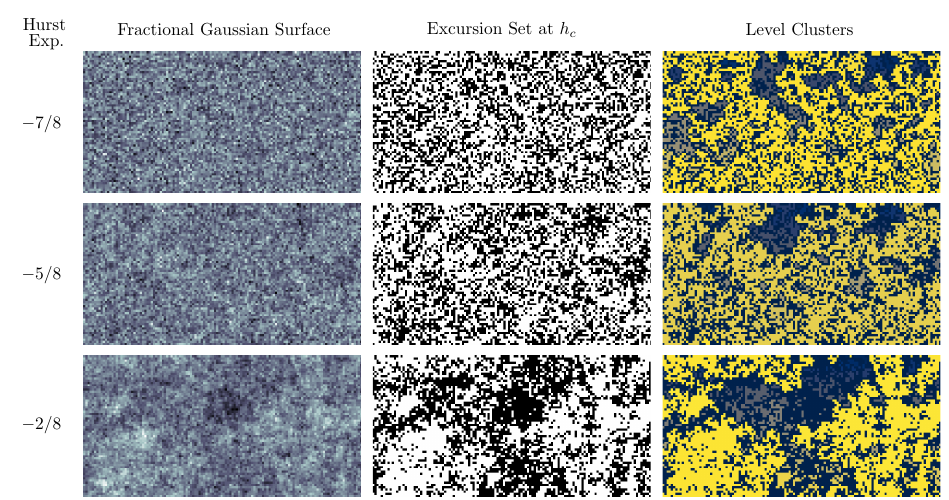
Figure 1: Instances of the fractional Gaussian surfaces (4) for H ∈ {− 7 / 8, − 5 / 8, − 2 / 8 } , generated on a M × N square lattice with M = 2 N , N = 2 6 . The excursion sets (white points) corresponding to level h = h shown in the second column, while the third column shows the level clusters. The yellow points in the third column are the points belonging to the percolating level cluster. Note that by increasing H , i.e. the correlation, the level clusters have less holes. This is consistent with the prediction that the fractal dimension D H → 0 −